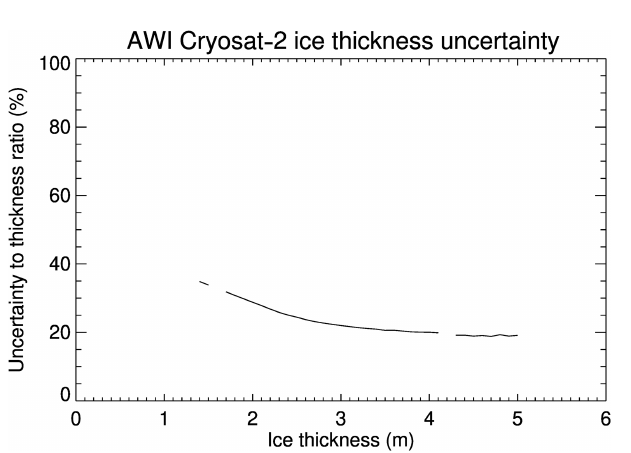
Figure A1. The percentage of uncertainty to sea ice thickness in AWI CryoSat-2 monthly mean ice thickness 2011–2018.